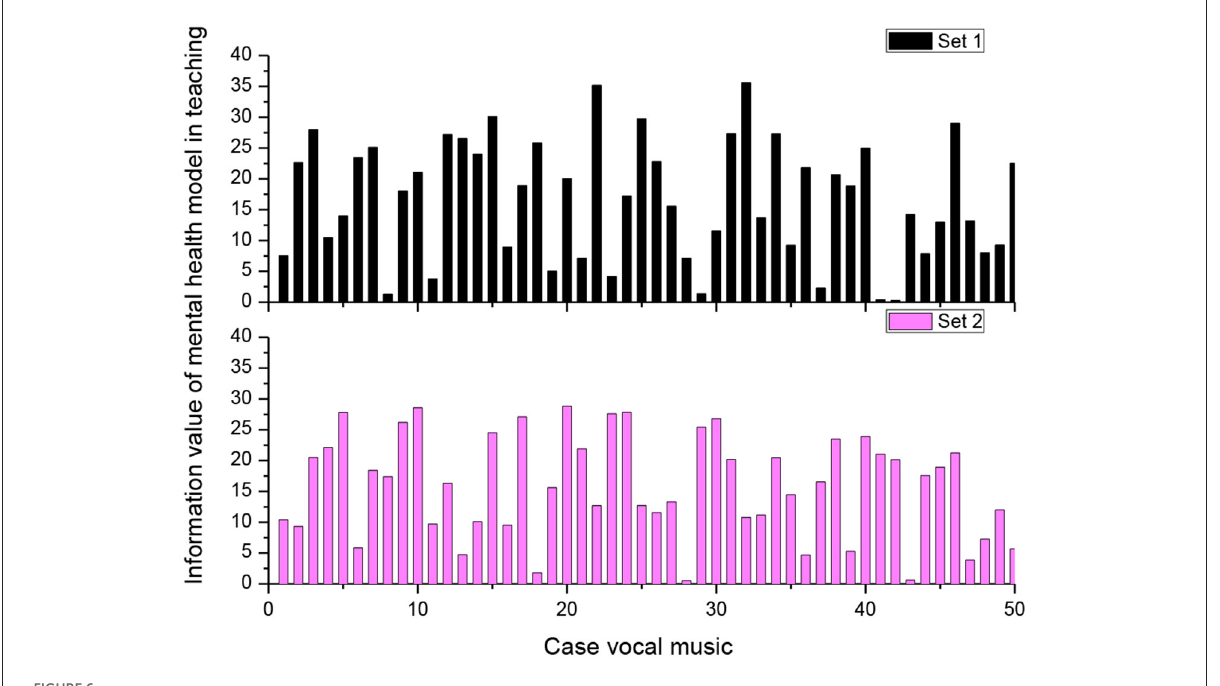
FIGURE6 Information on the mental health model of vocal music